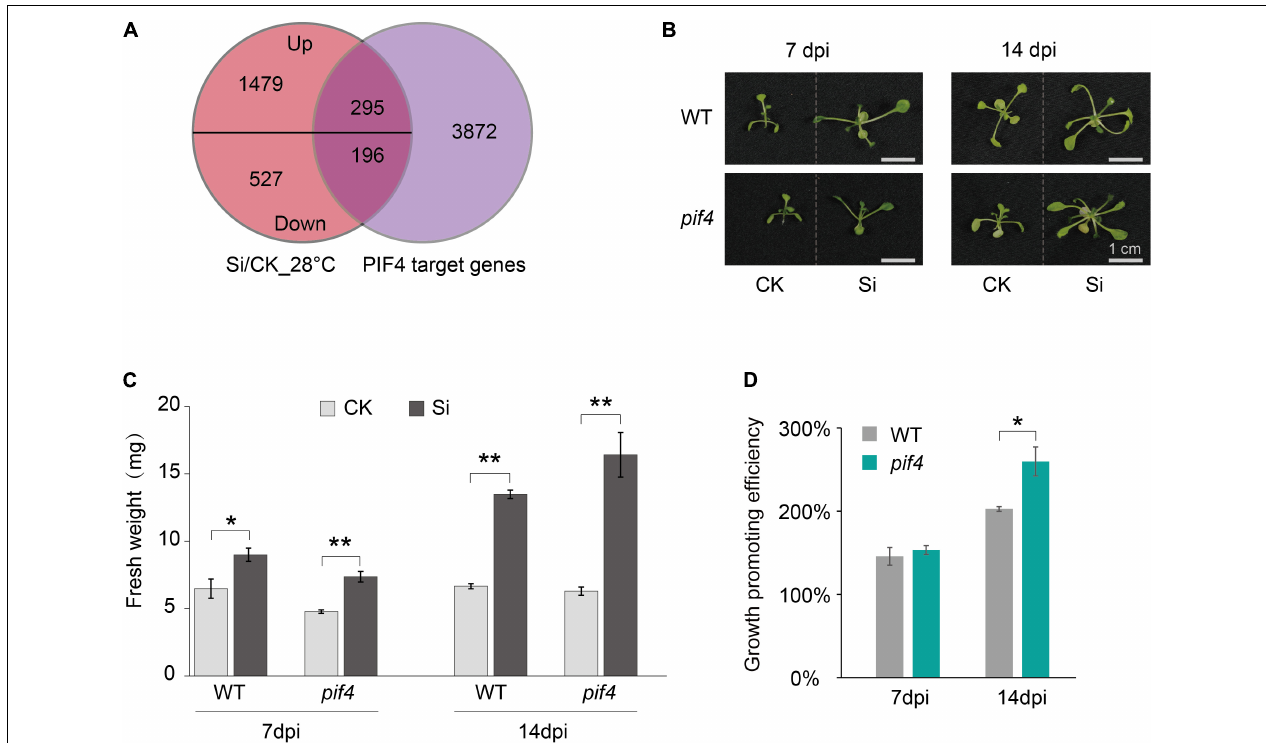
FIGURE 5 | PIF4 regulated the growth promotion efficiency of S. indica in Arabidopsis under high ambient temperature. (A) Venn diagram showing that PIF4 target genes overlapped with many upregulated or downregulated DEGs during the systemic response of Arabidopsis aboveground parts to S. indica at high ambient temperature (28 ◦ C). (B) S. indica -incubated seedlings (Si) at 7 or 14 dpi and their control (CK) seedlings. (C) The fresh weight of wild-type (WT) and pif4 plants at 7 and 14 dpi when cocultured with S. indica at 28 ◦ C. (D) The growth promotion efficiency of S. indica on pif4 ( pif4-101, a pif4 loss-of-function mutant) plants was higher than that on WT plants at 28 ◦ C. Growth promoting efficiency was obtained by dividing the fresh weight of Si samples by that of CK samples. Error bars indicate SE ( n ≥ 3). Significance analysis of differences were performed by t -test (** P < 0.01; * P <